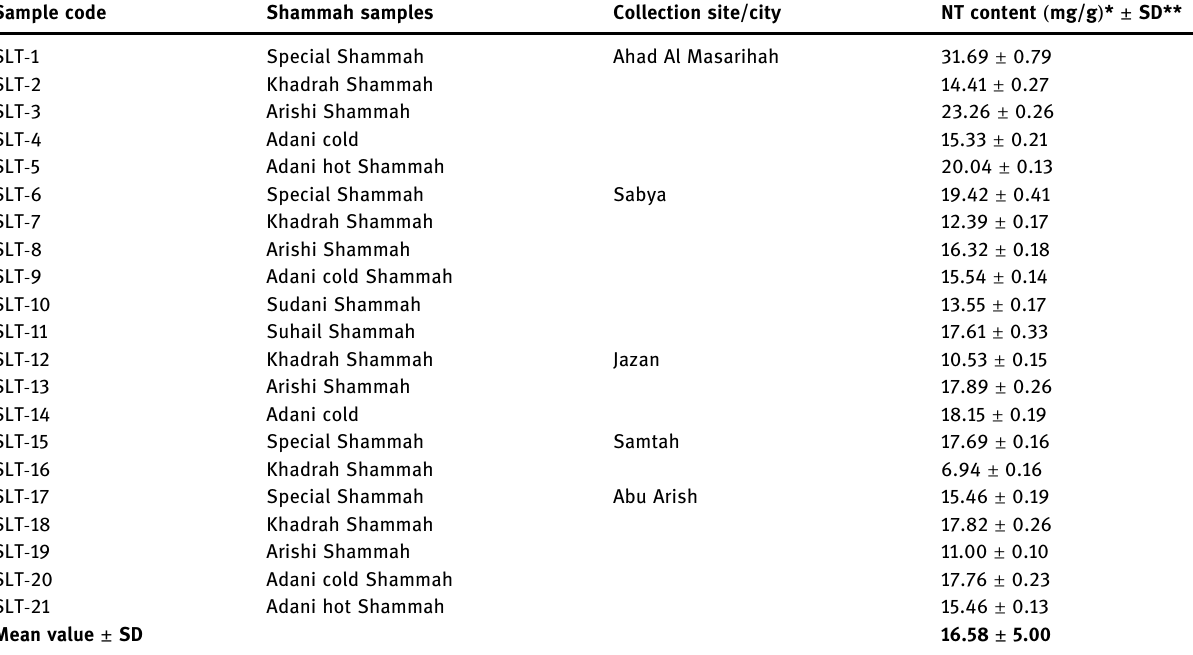
Table 3: Nicotine contents observed in di ff erent Shammah samples collected from Jazan region of Saudi Arabia Sample